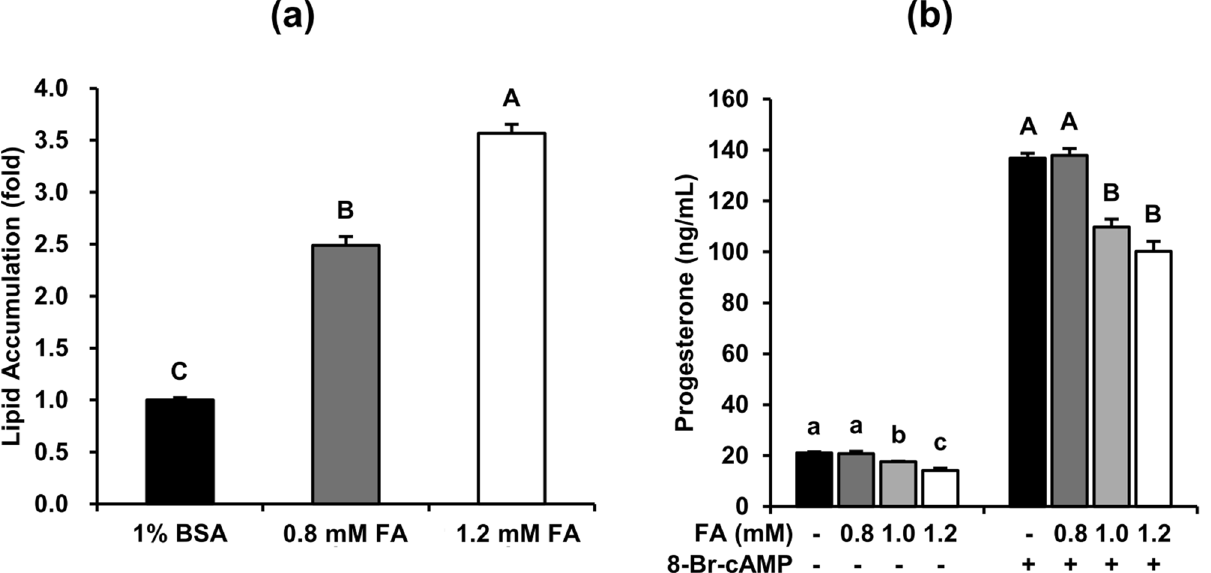
Figure 1. Fatty acids induce lipid accumulation and inhibit the steroidogenesis of MA-10 cells. MA-10 cells were treated with 1% BSA, 0.8 mM (0.4 mM PA mixed with 0.4 mM OA) to 1.2 mM fatty acids (0.6 mM PA mixed with 0.6 mM OA) for 48 h. The cells were then stained with Nile Red to quantify lipid accumulation and with Hoechst 33,342 to normalize the cell numbers. ( a ) The relative lipid accumulation under different FA dosages is shown as the means ± standard errors of the mean (SEM) (n = 3). After FA treatment for 48 h, MA-10 cells were treated with or without 50 µM 8-Br-cAMP for 4 additional hours to induce steroidogenesis. Conditioned medium was then collected to measure steroidogenesis. ( b ) The progesterone levels in the conditioned medium are shown as means ± SEM (n = 3). Different letters represent a significant difference between groups analyzed by one-way ANOVA followed with Duncan’s multiple comparisons (p <